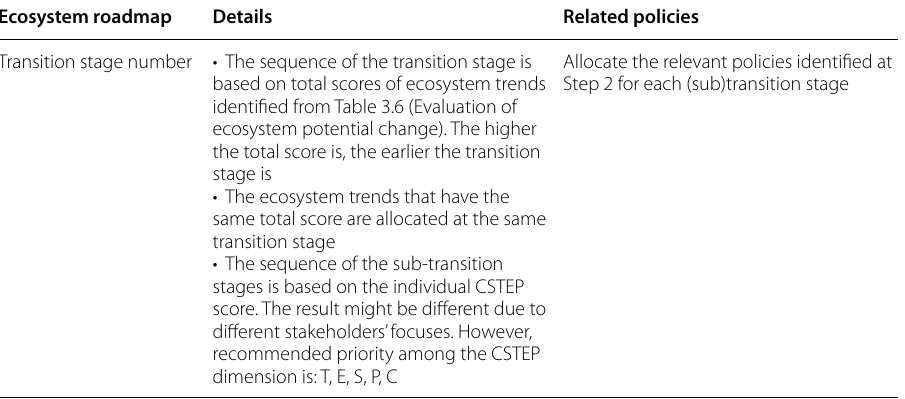
Table 17 Identified transition stages and related policies Ecosystem roadmap Details Related